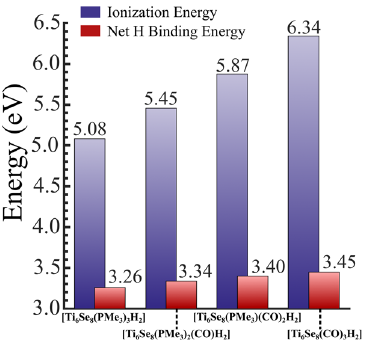
Fig. 7 Ligand-induced alteration of AIE and net hydrogen binding energy of intermediate 2. The trend in the adiabatic ionization energy (AIE) and the net hydrogen binding energy of intermediate 2 for